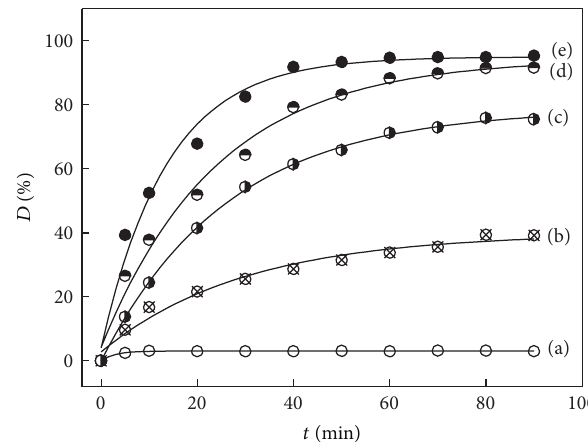
Figure 3: The FTIR spectra of (a) PAN nanofiber, (b) AO-n-PAN, and (c) Fe-AO-n-PAN. Figure 4: Variations in